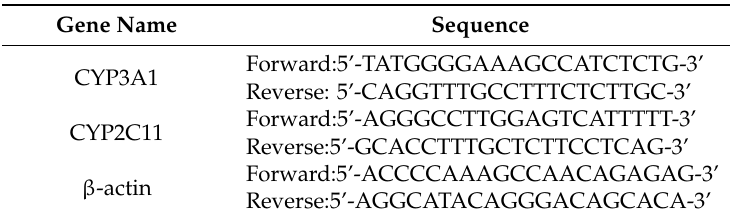
Table 1. Primer sequences for real-time